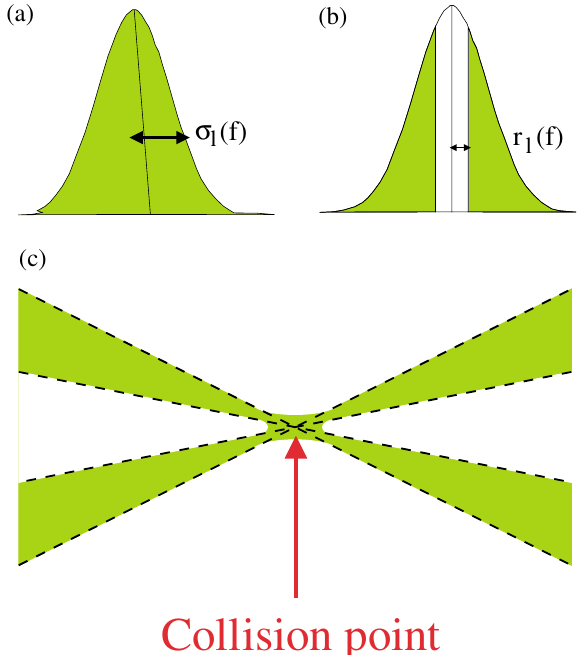
FIG. 18. (Color) Distribution of the laser beam: (a) before injection on the parabolic mirror; (b) after injection on the parabolic mirror; (c) around the collision